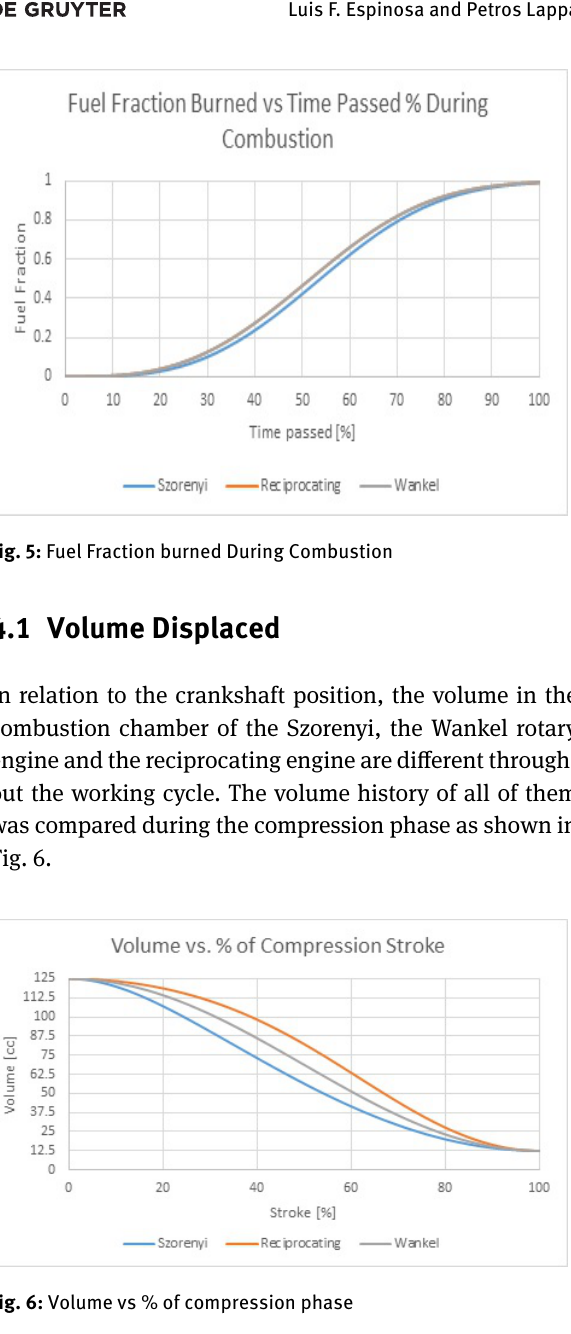
Fig. 6 indicates that the Szorenyi engine has the slow- est and better rate of volume change near TDC and the fastest nearBDC. Aslower rateof changenear TDC iscloser to the ideal Otto cycle because it brings a steadier volume for combustion. Therefore, a higher fuel mass fraction is burned.